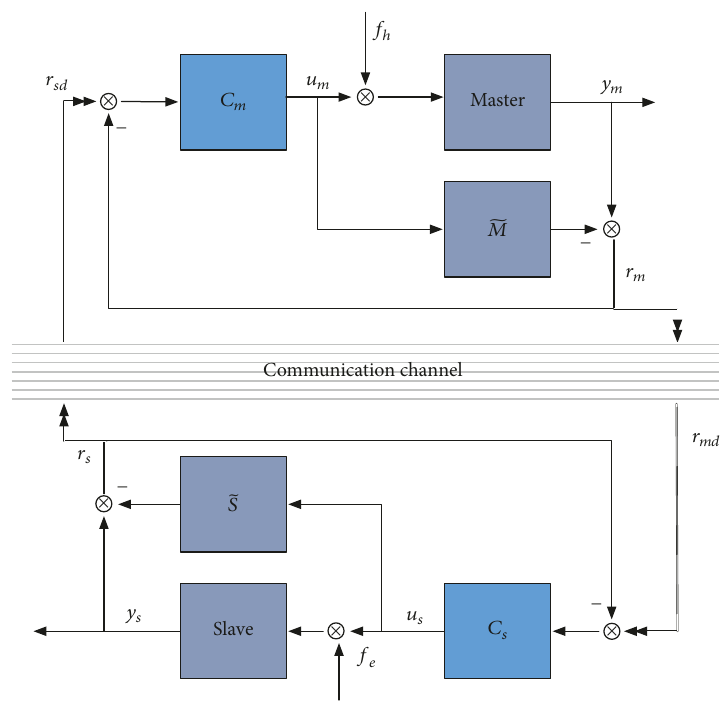
Figure 3: IMC structure of teleoperation